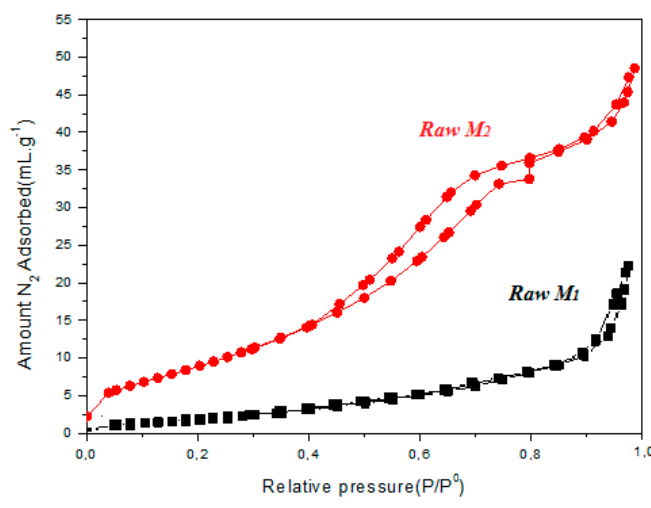
Figure 4. Nitrogen adsorption–desorption isotherms for raw materials M 1 and M 2 .